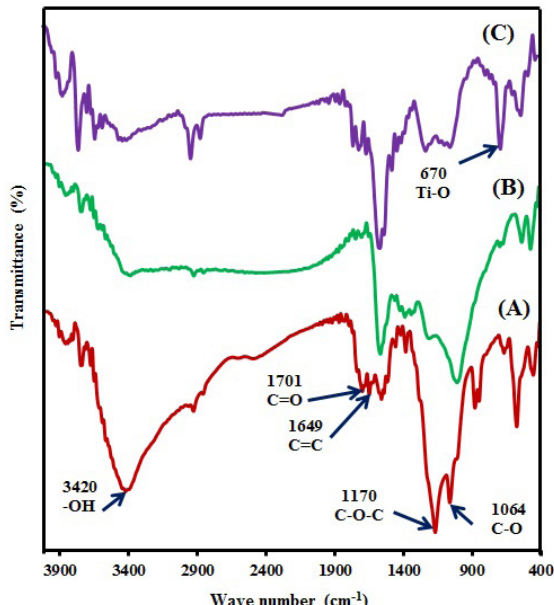
Fig. 3. FT-IR spectra of GO (A), RGO (B), and RGO/TiO